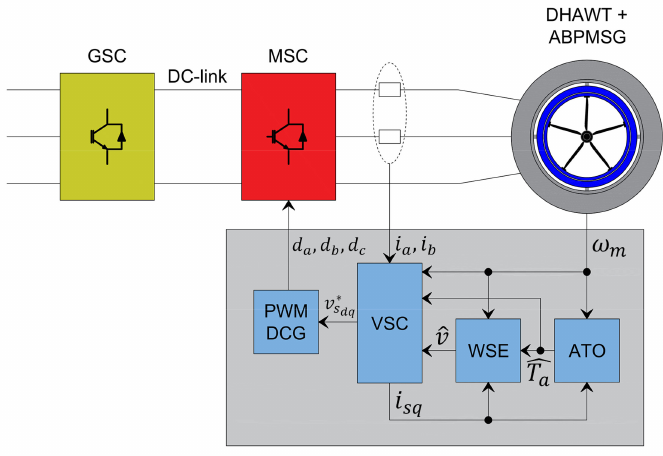
Figure 1. Wind energy conversion system (WECS)